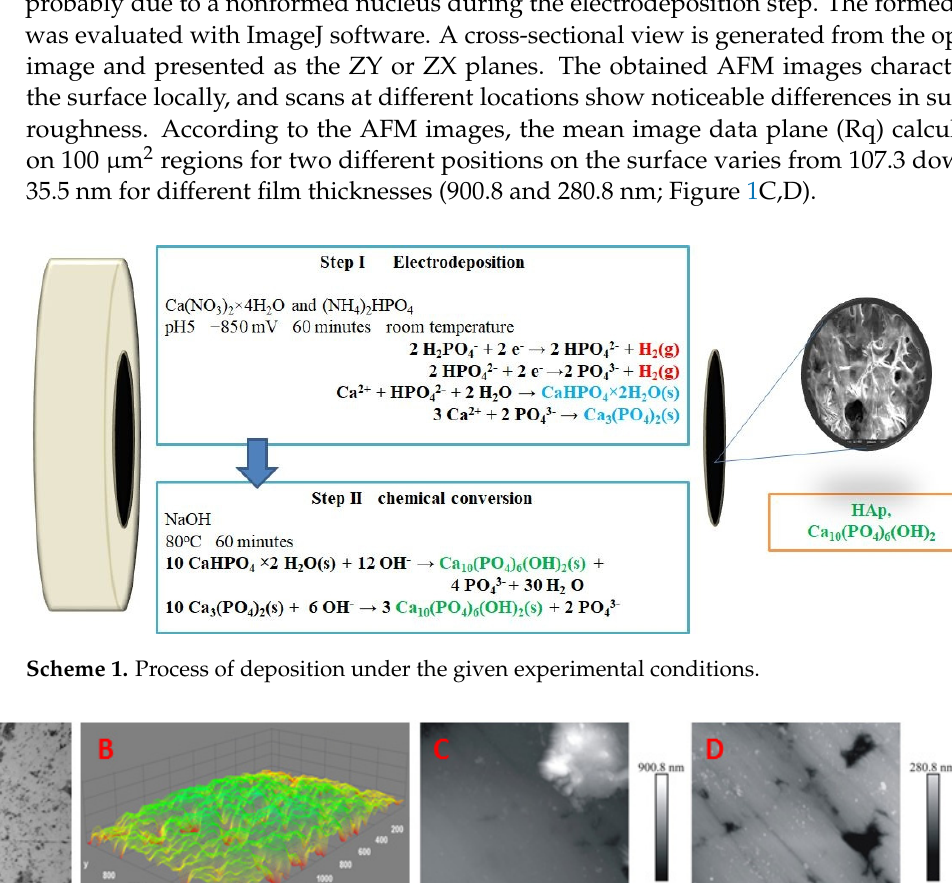
Figure 1. Optical image of the HAp film at 500× magnification: ( A ) cross-sectional view generated from the optical image ( B ) and film thickness measurements using AFM ( C , D ).